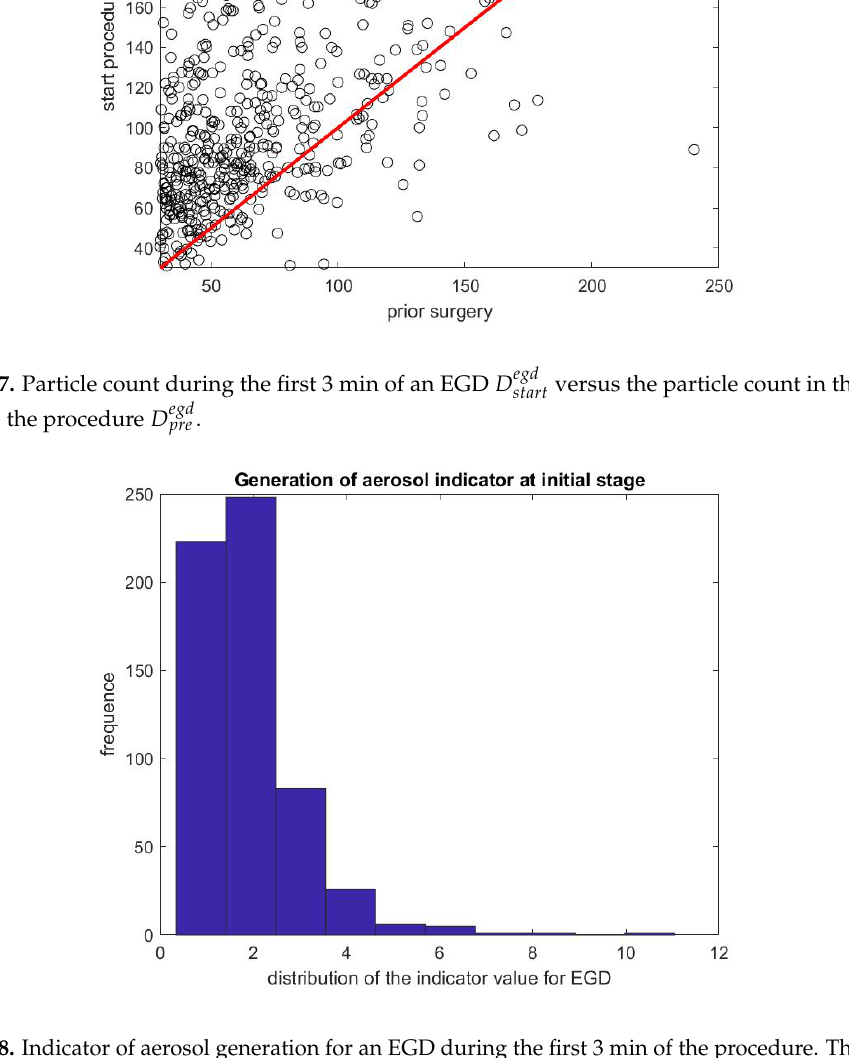
egd start D egd pre